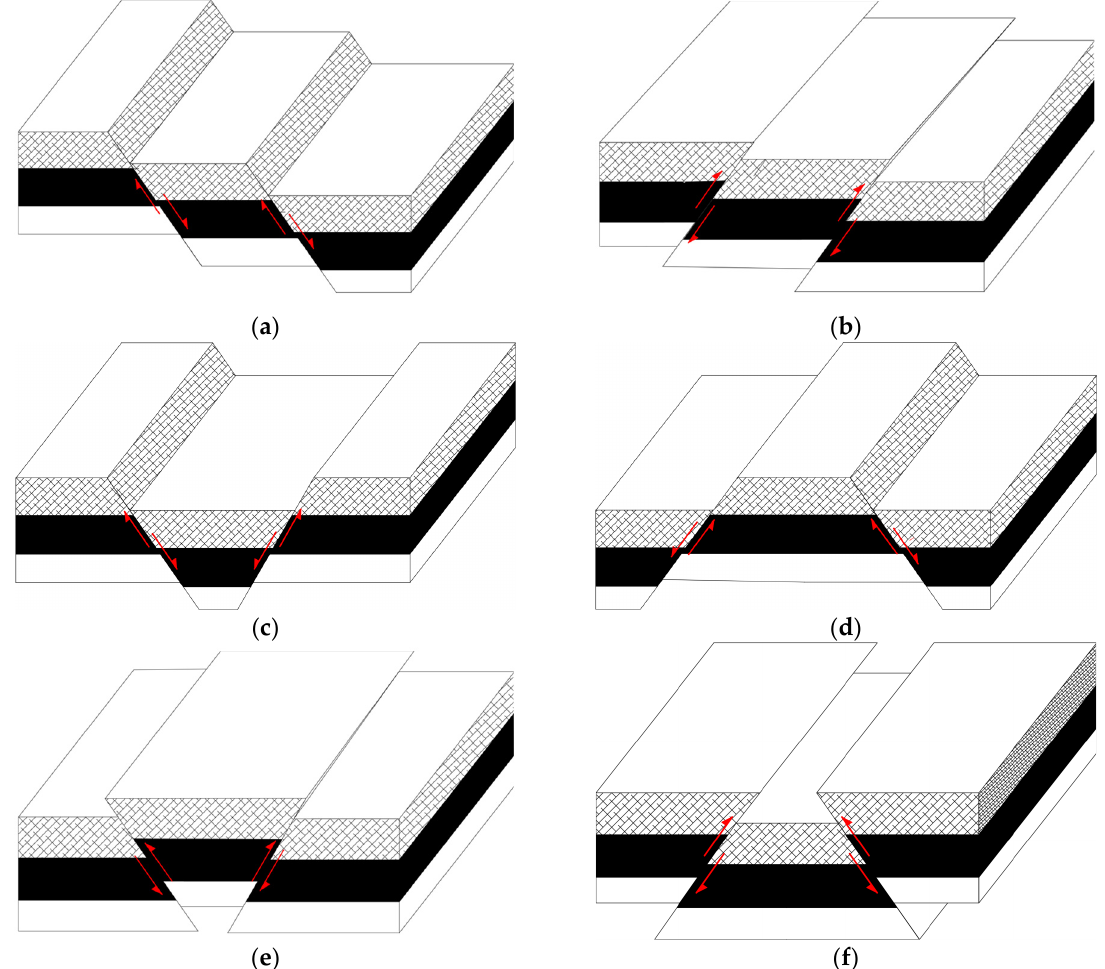
Figure 1. The scheme of the different two combined faults. ( a ) Plane view represents stair-stepping fault. ( b ) Plane view represents imbricate fault. ( c ) Plane view represents graben fault. ( d ) Plane view represents horst fault. ( e ) Plane view represents back thrust fault. ( f ) Plane view represents ramp fault. The red arrows represent the moving direction of the fault block. The black fill represents coal seams and others represent other sedimentary formations.